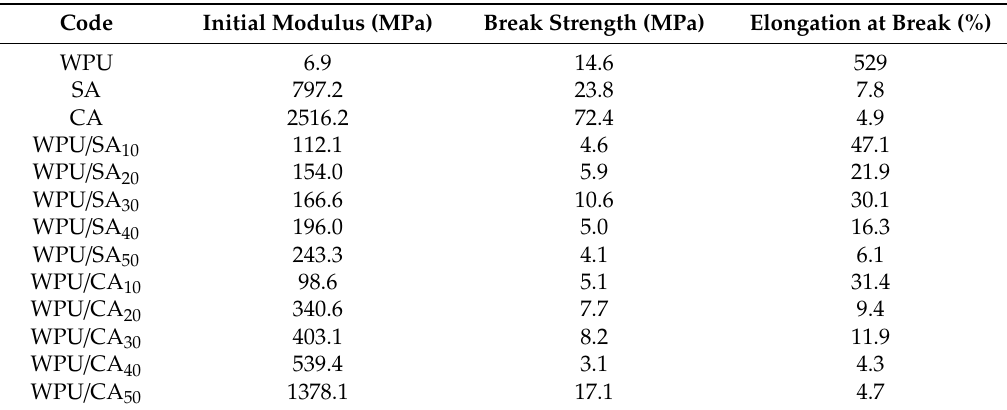
Table 3. Tensile strengths of the WPU, SA, CA, WPU / SA, and WPU / CA